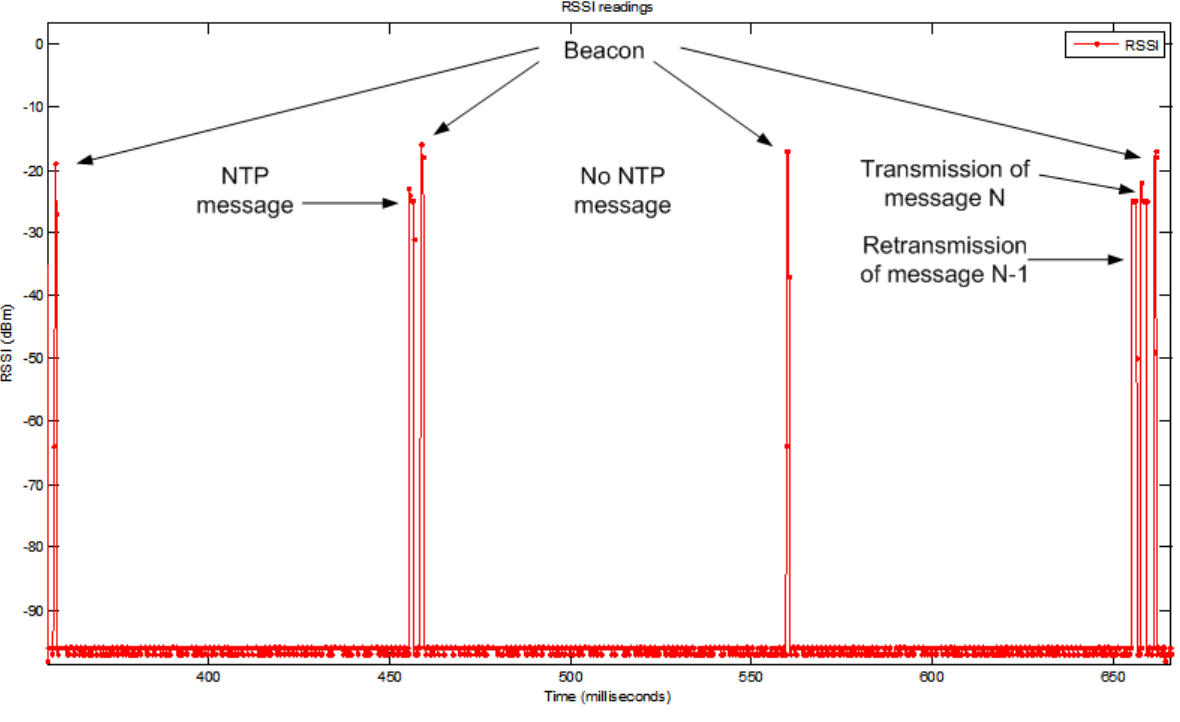
Figure 14. Example of operation of the contention-free retransmission